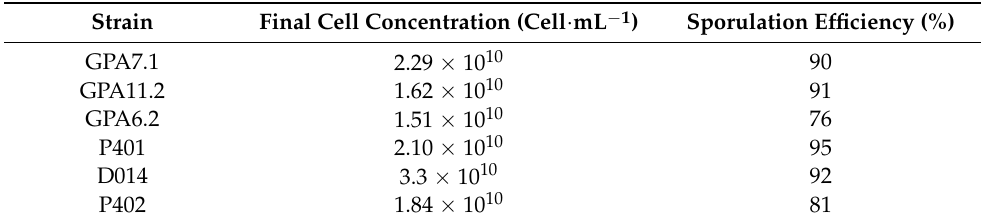
Table 2. Summary of cell concentration (cell · mL − 1 ) and sporulation efficiency (%) obtained post- fermentation for the selected strains.